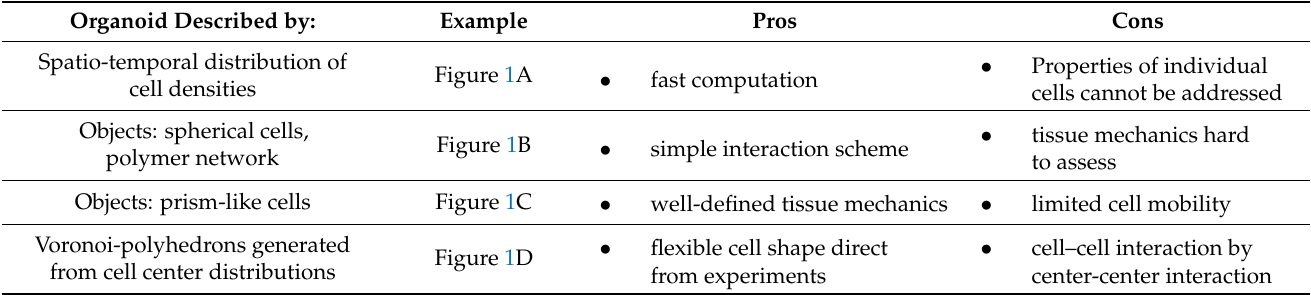
• cell–cell interaction by center-center